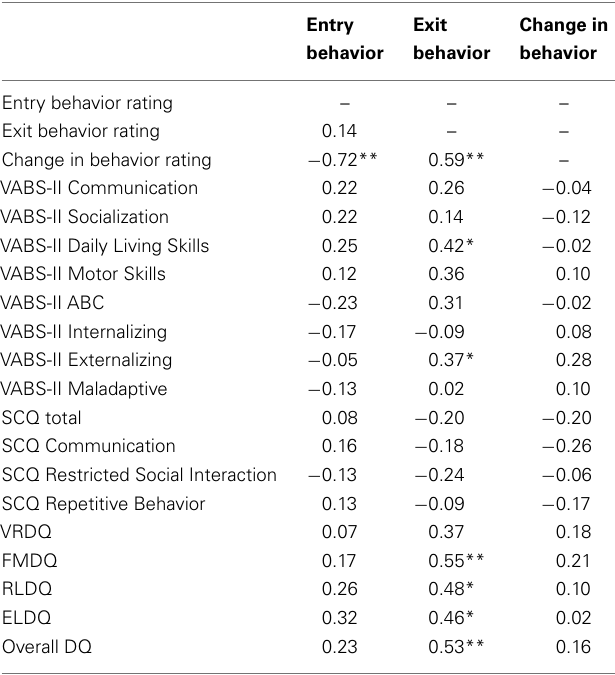
Table 2 | Correlations between clinician-rated behavior scores and baseline clinical variables